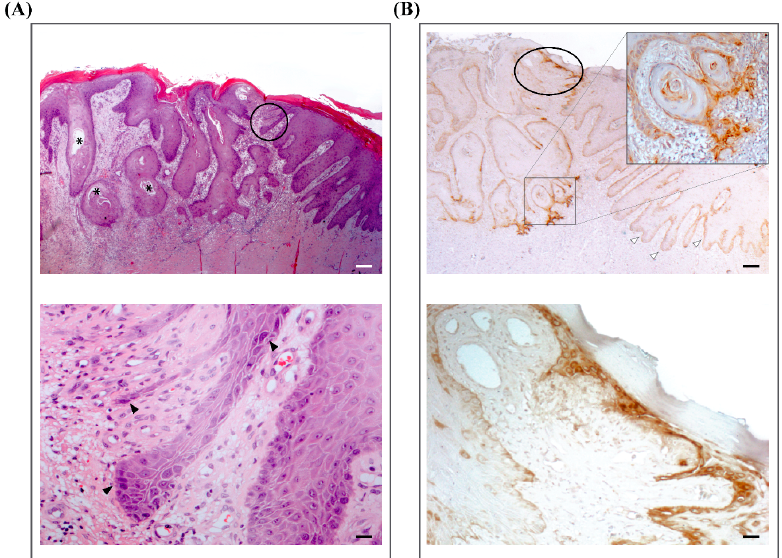
Figure 3. Laminin-332 expression in patient squamous cell carcinomas (SCCs). ( A ) Upper panel. Histopatological characteristics of a representative cutaneous SCC of the patient.